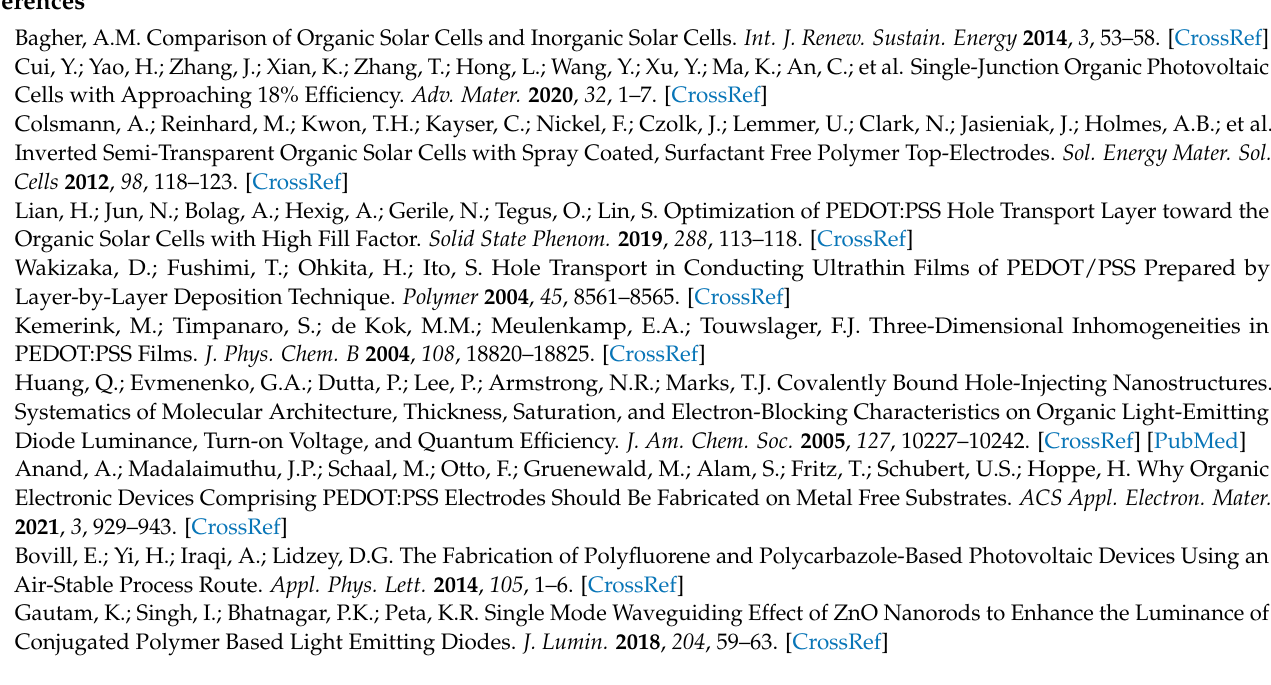
Figure S2: AFM measurement for out of stoichiometry CuCrO 2 thin films, Figure S3: Transmittance spectra of the CuCrO 2 reference for various Cu cationic ratio in the solution, Figure S4: Statistical dispersion of the performances for OSC with out of stoichiometry CuCrO 2 thin films as HTL, Figure S5: Comparisonof J-V characteristic under A.M. 1.5 illumination of OSC with a HTL of PEDOT:PSS and of CuCrO 2 : 65%, Figure S6: Evolution as function of the time under atmospheric conditions of the performances of the